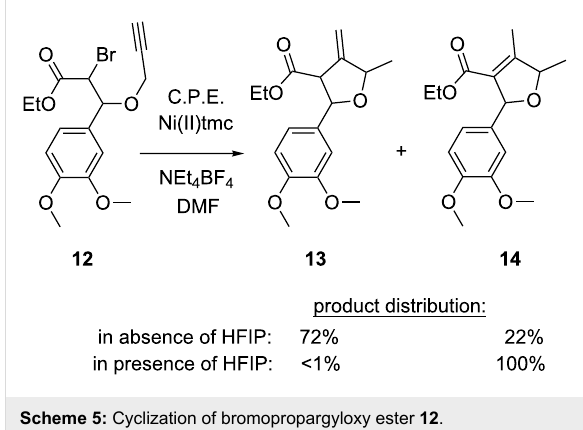
Scheme 5: Cyclization of bromopropargyloxy ester 12